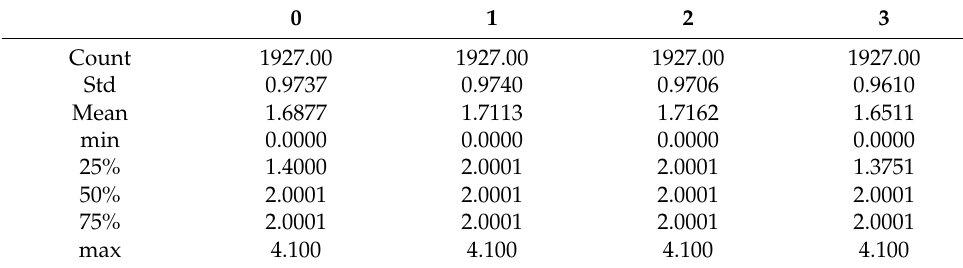
Table 6. Summary